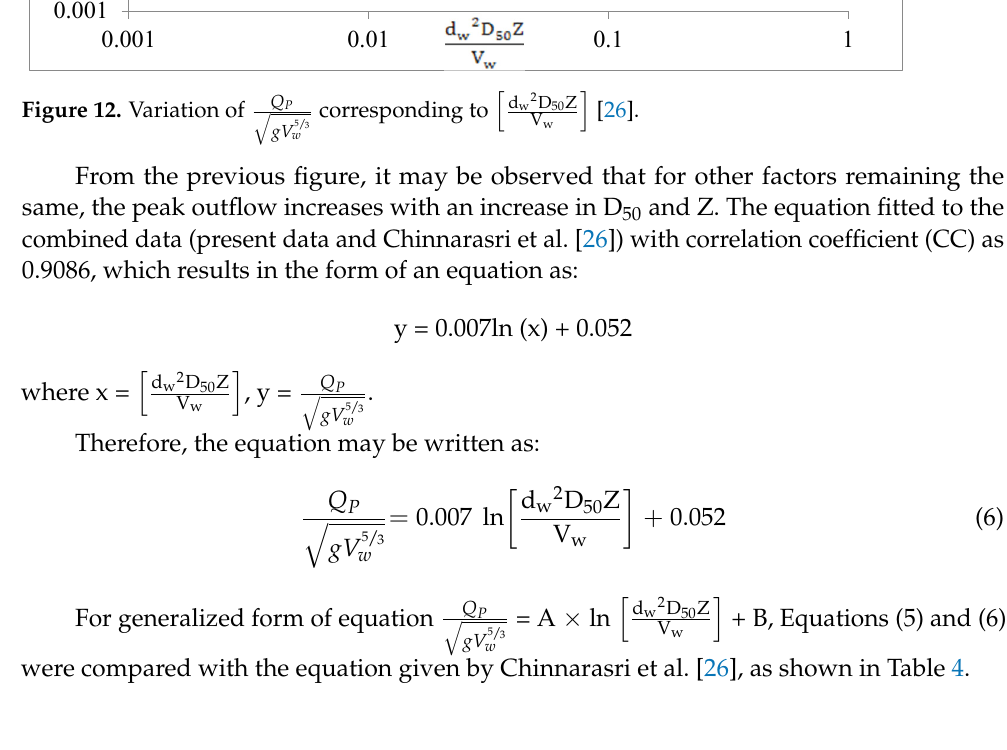
Table 4. Summary of coe ffi cients used in di ff erent equations.